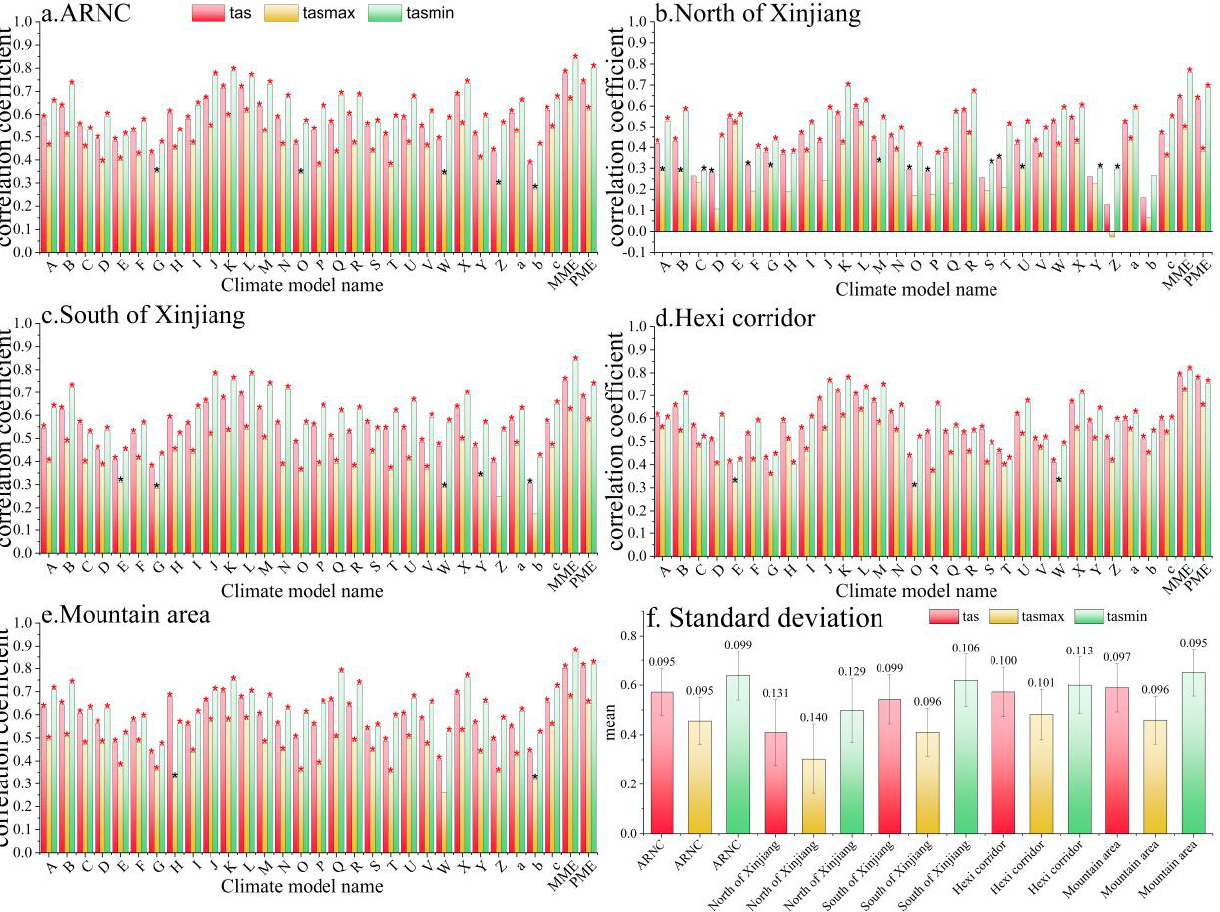
Figure 2. Correlation coefficient between the simulation data by CMIP6 model and the observation data by CN05.1 for the three temperature elements, tas, tasmax and tasmin, in the ARNC and subregions during 1961–2014 ( a – e ). Letters represent model ID listed in Table 2. The red star indicates the statistical test is significant at the 1% significance level, and the black star indicates it is significant at the 5% significance level. The standard deviation and mean of correlation coefficient between the simulation data and observation data for the three temperature elements in the ARNC and subregions during 1961 – 2014 ( f ).